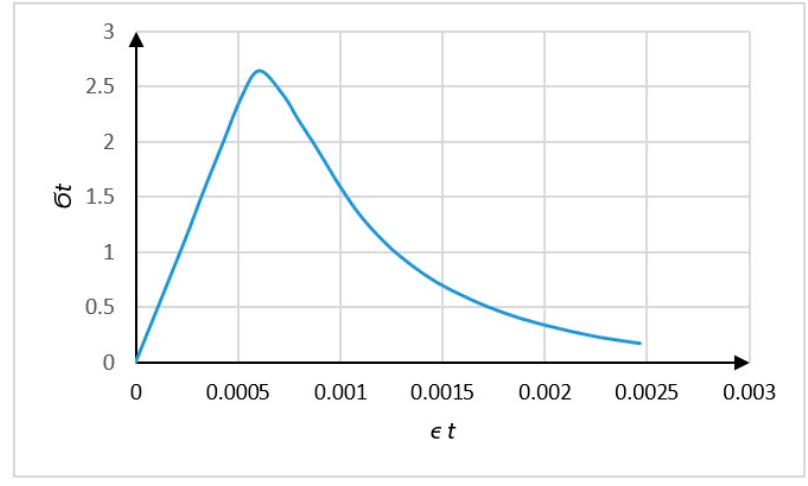
Figure 11. Stress-strain curve for compression stress in concrete .